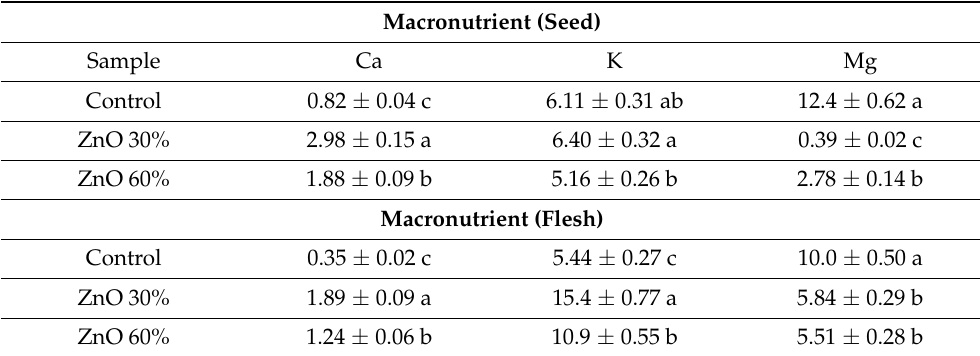
Table 2. Average content ( n = 3) of Ca, K and Mg (%) in grape flesh and seeds (after dehydration) in Fern ã o Pires grapes at harvest and the respective degree of uncertainty. Letters a, b, c indicate significant differences between treatments ( p < 0.05). Treatments ZnO with concentrations of 0%, 30%, 60%. (i.e., 0, 450 and 900 g ha − 1